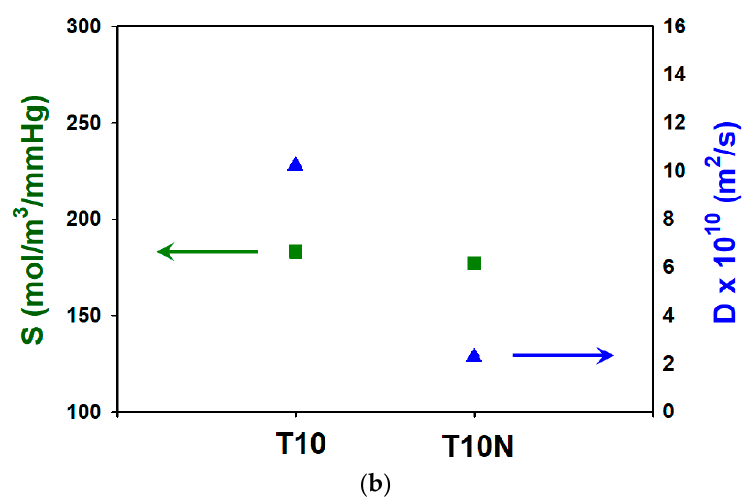
Figure 11. Dimethyl methylphophonate (DMMP) ( a ) permeabilities and ( b ) sorption and diffusion coefficients for T10 and T10N.